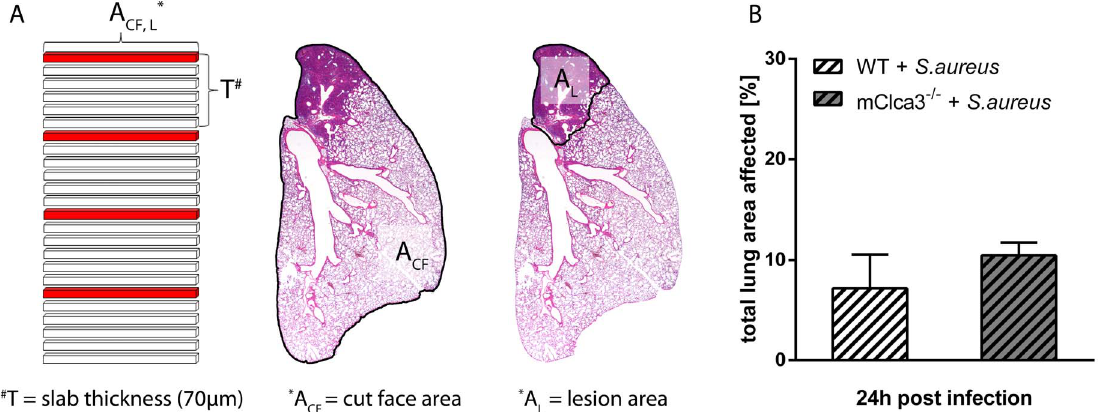
Figure 9. mCLCA3 had no impact on severity or expansion of lung inflammation. (A) 24 hours after infection, left lungs of Staphylococcus aureus infected mice were used for quantification of lung lesions by Cavalieri principle. (B) Percentages of estimated lung lesion volumes and total lung volumes of the left lungs were calculated. Values are given as mean 6 SEM (n=4 each group).